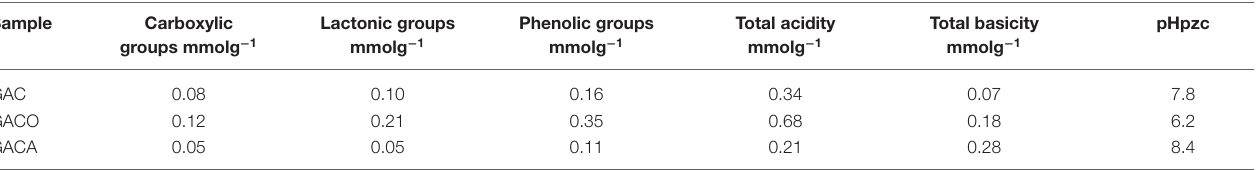
TABLE 4 | Oxygenated surface groups content determined by the Boehm method, and the pH at the point of zero charge for the carbonaceous materials.